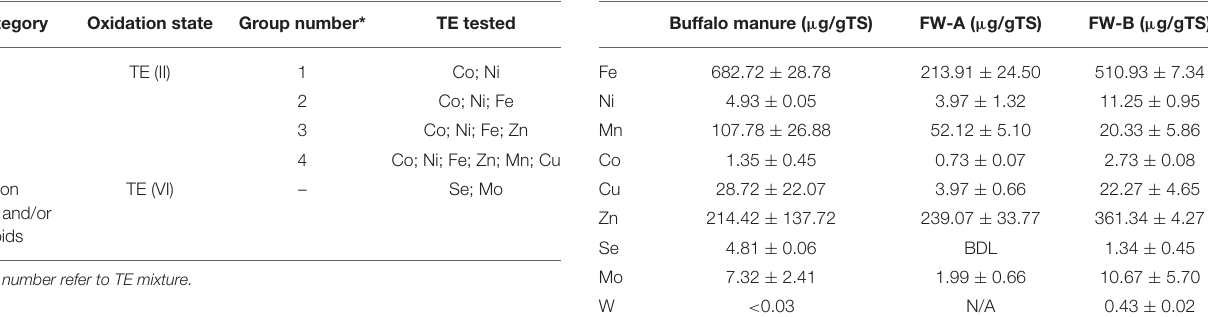
TABLE 1 | Trace elements groups used in this research. TABLE 2 | Concentration of TE in the FW and